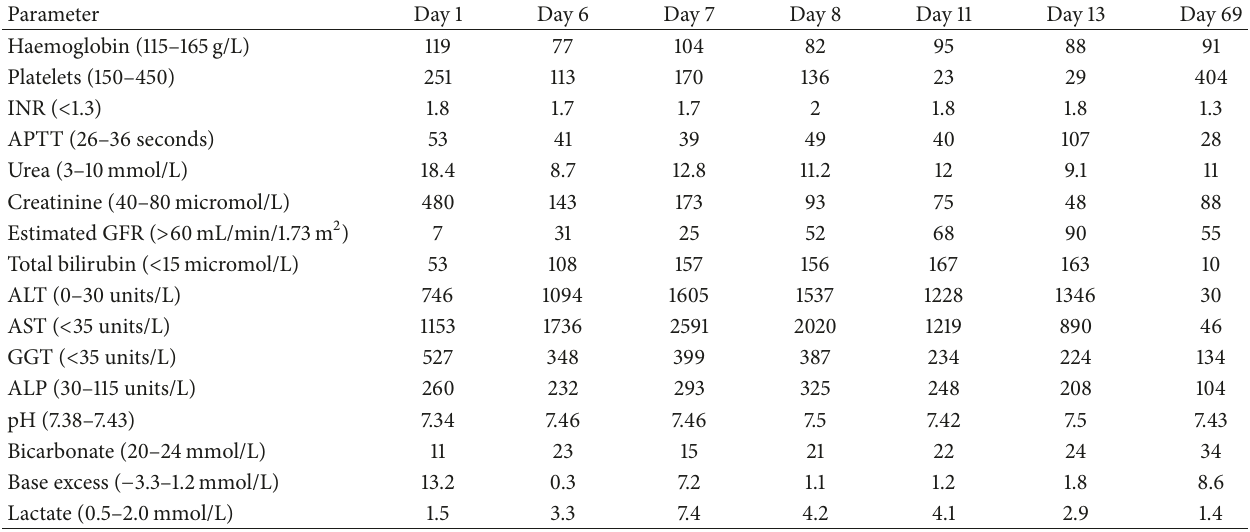
Table 1: Changes in haematological and biochemical parameters during the course of the disease.